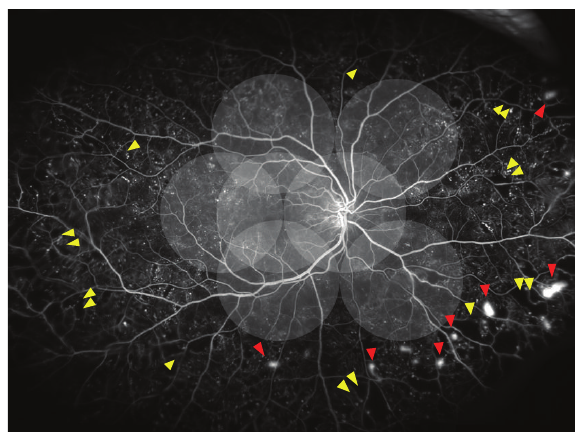
Figure 1: Diagram illustrating the extent of the seven standard ETDRS fields (the 75 ∘ view) on an ultrawide field fundus photo (the 200 ∘ view). Ultrawide field fundus angiography of a patient with proliferativediabeticretinopathywithextensiveperipheralischemia and extensive retinal neovascularization at the border between the perfused and nonperfused